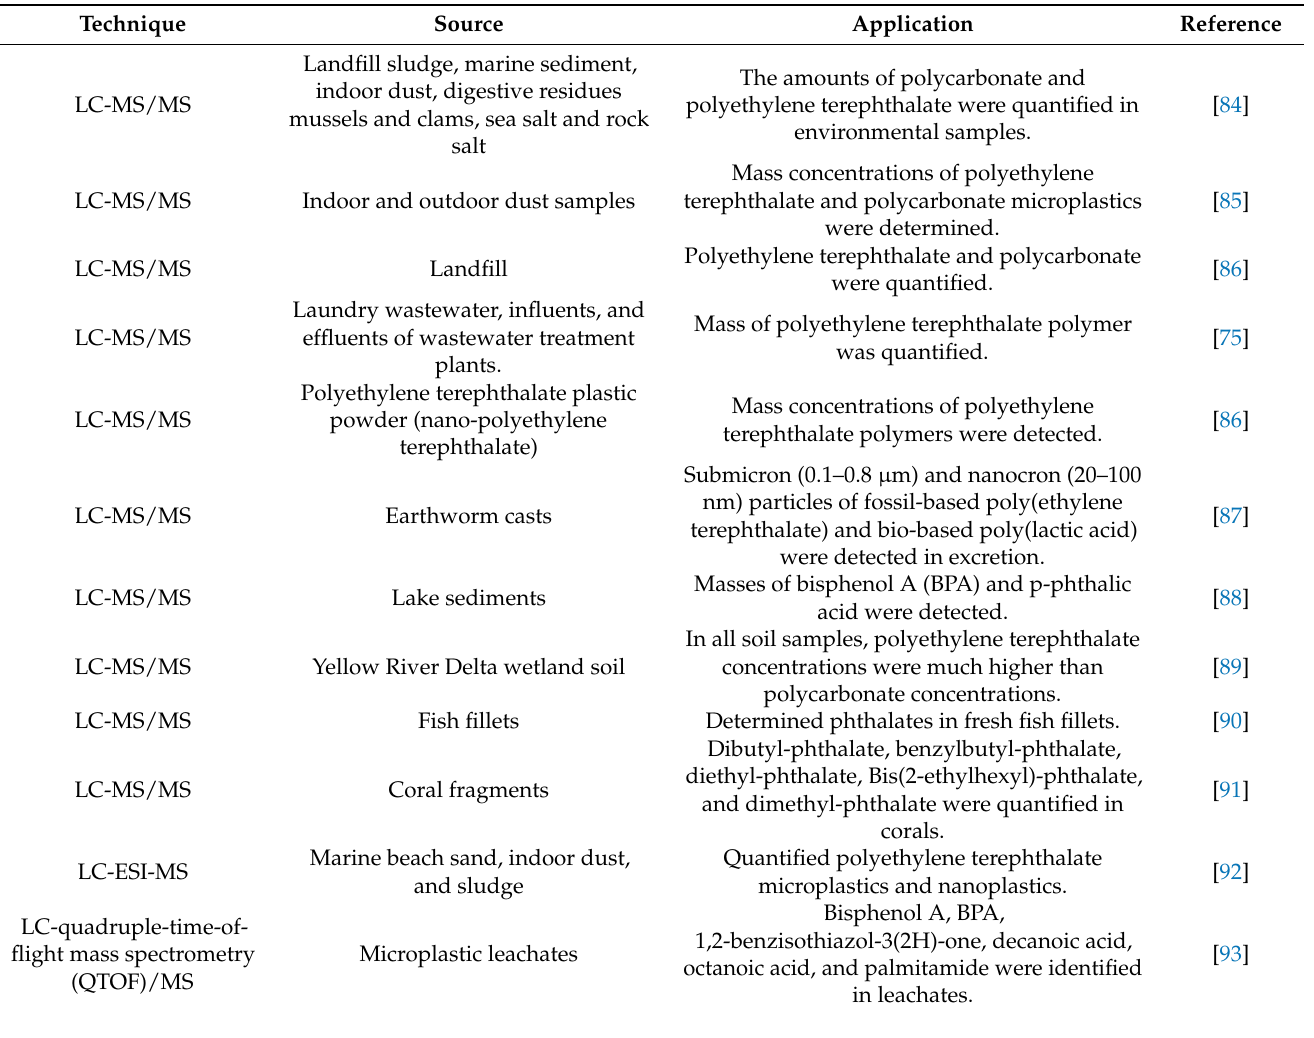
Table 2. LC-MS as microplastic